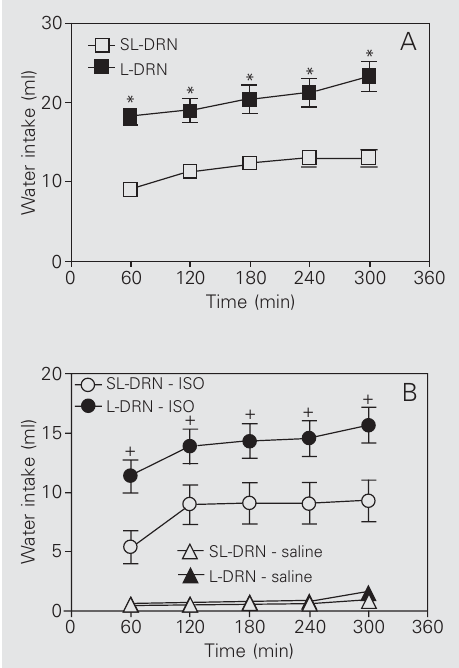
Figure 2. A , Water intake by dor- sal raphe nucleus-lesioned (L- DRN, filled squares) and sham- lesioned (SL-DRN, open squares) rats deprived of water for 16 h. B , Water intake by isoproterenol (ISO)- (L-DRN, filled circles; SL- DRN, open circles) or isotonic saline- (L-DRN, filled triangles; SL-DRN, open triangles) treated rats. Data are reported as means ± SEM. *P < 0.0001 compared to the SL-DRN group (panel A). + P < 0.05 compared to the SL- DRN group (panel B) (two-way ANOVA followed by the New- man-Keuls